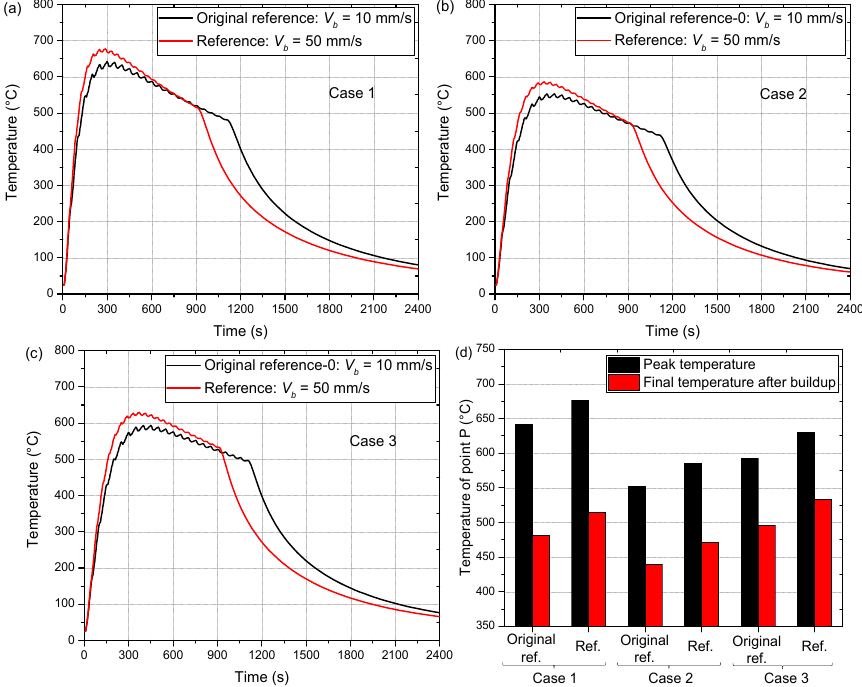
Figure 8. Temperature histories of point P (see Figure 3): ( a ) Case 1; ( b ) Case 2; ( c ) Case 3; ( d ) comparison of peak and final temperatures after the last layer for the three cases.